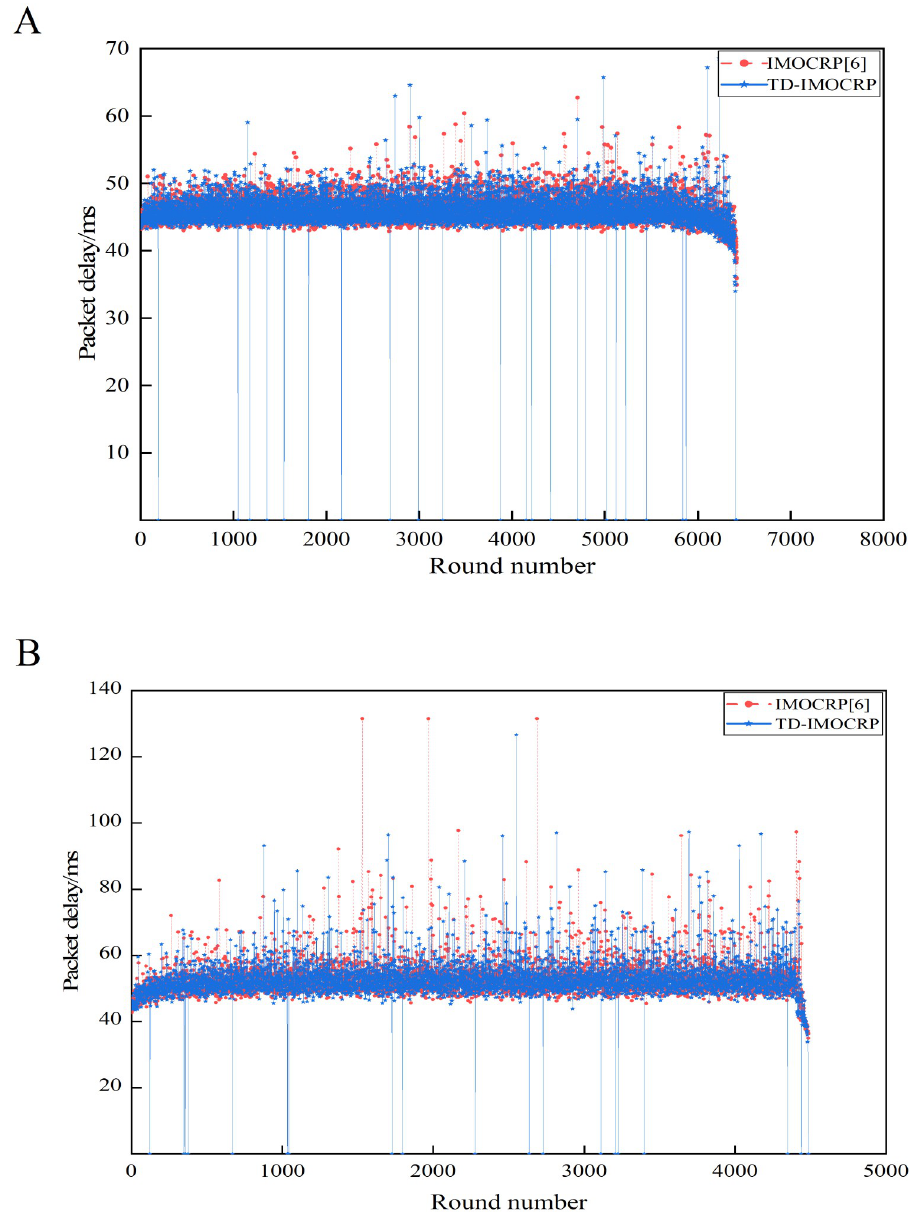
Fig 9. Comparison results of data packet delay. (A) The sink is located at the center. (B) The sink is located at (0,0).